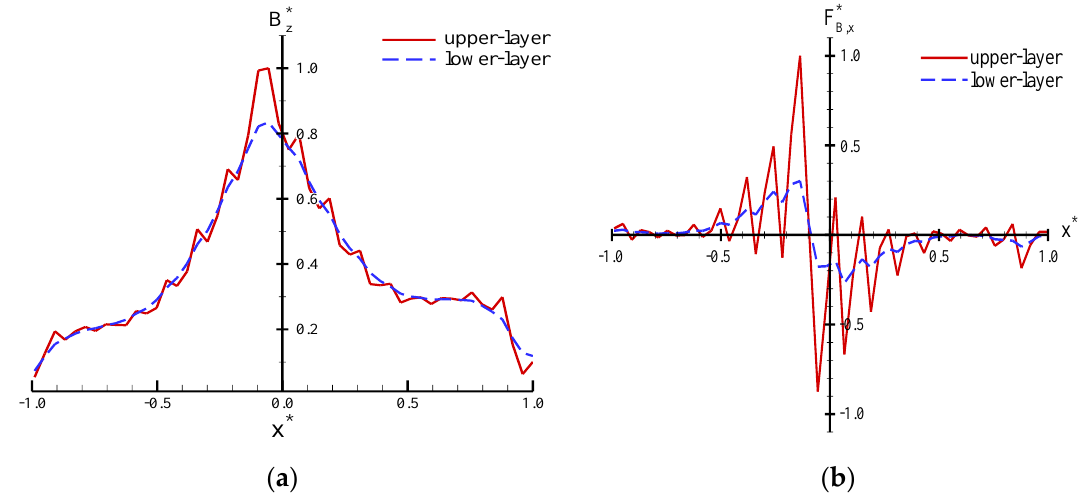
Figure 5. Numerical profiles of the dimensionless ( a ) B* Z and ( b ) F* B,X varied along with x*.